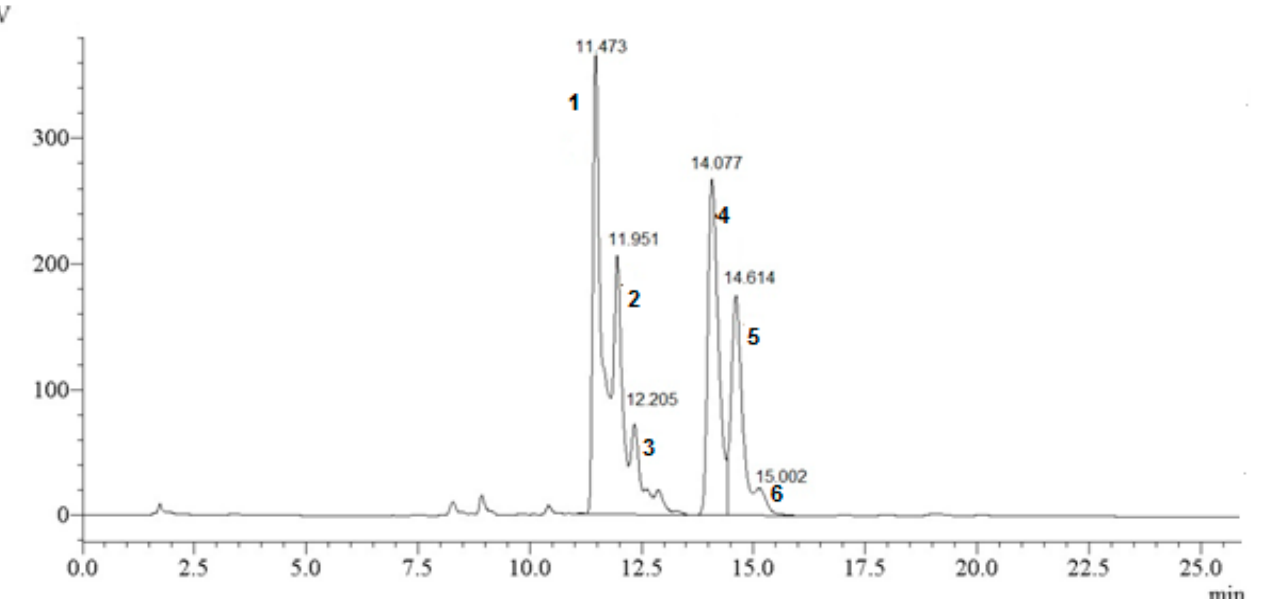
Figure 1. Chromatogram of flavonoids in parsley grown on different organic substrates: (1) apigenin-7-apiosylglucoside (apin), (2) diosmetin-apiosylglucoside, (3) diosmetin-apiosylglucoside isomer, (4) apigenin-malonyl-apiosylglucoside (malonyl apin), (5) diosmetin-malonyl-apiosylglucoside, (6) apigenin-malonylglucoside.